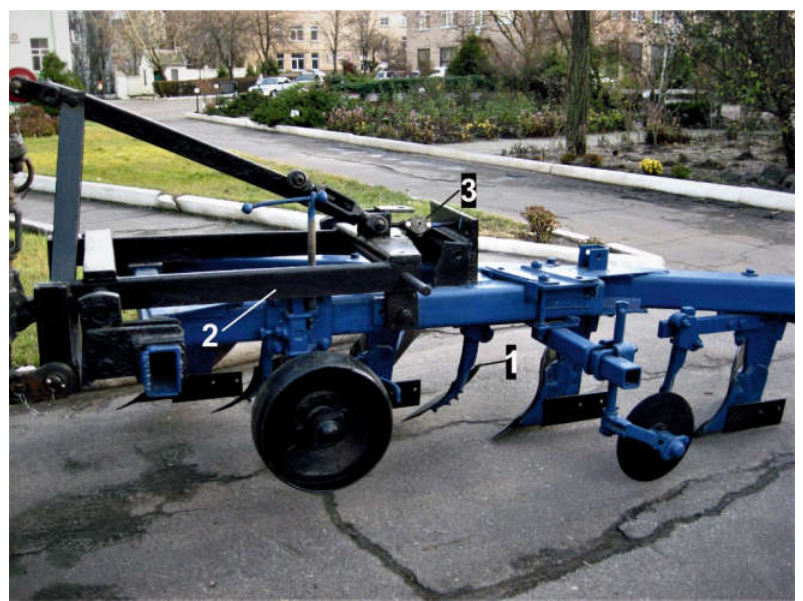
Figure 2. PLN-5-35, equipped for traction resistance measurements: 1—skimmer; 2—strain gauge frame; 3—load cell.